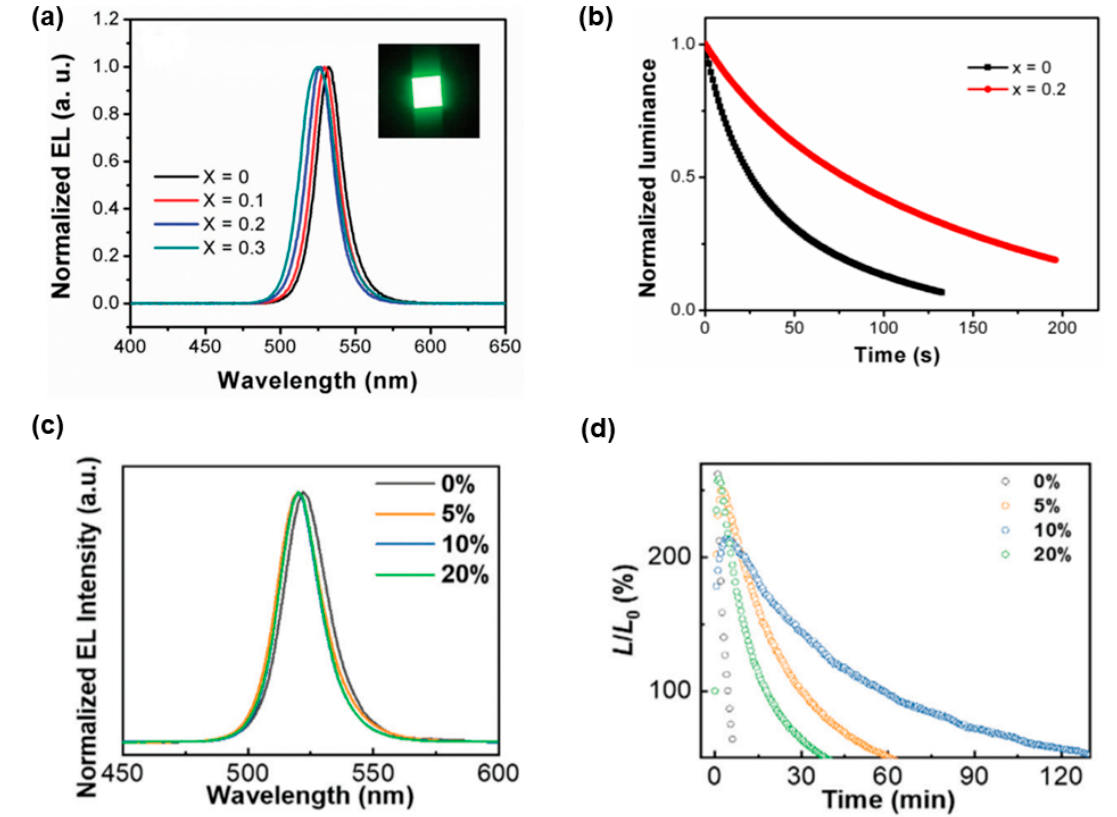
Figure 4. ( a ) EL spectra and photograph (under 4 V) for PeLEDs with different amounts of Cs doping and ( b ) Lifetime of PeLEDs with neat FAPbBr 3 and mixed cation (Cs doping x = 0.2). Reproduced from reference [158], John Wiley and Sons, 2017. ( c ) EL spectra and ( d ) EL stability of PeLEDs based on the perovskite precursor solution incorporated with different amounts of MgBr 2 (under a constant applied voltage). Reproduced from reference [167], Royal Society of Chemistry, 2016.